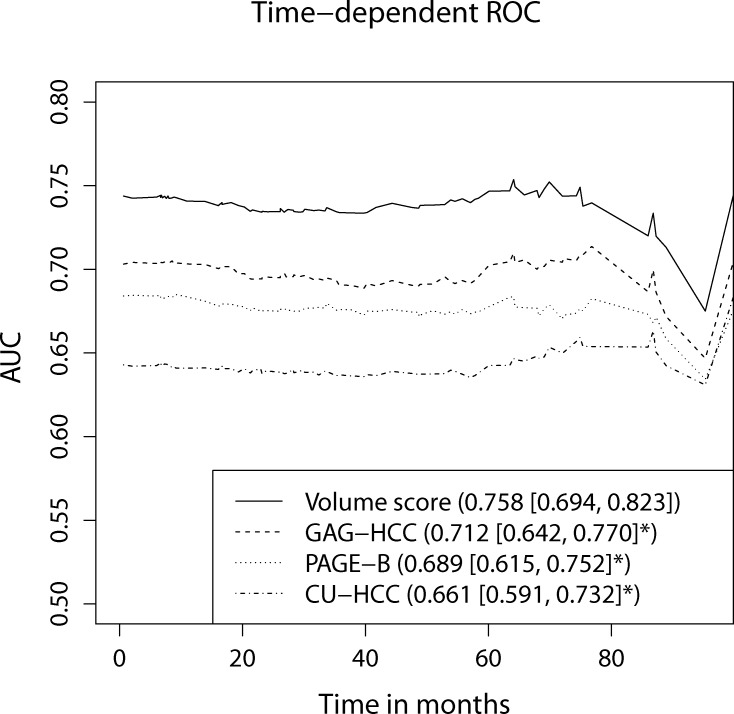
Comparison of HCC probability prediction models by time-dependent ROC analyses.The nomogram-based liver volume score model was compared to previously reported three HCC prediction models. The area under ROC curves (AUCs) were plotted over time for each prediction models. The numbers indicate the integrated AUCs after 100 bootstrapping iterations [95% confidence interval]. Asterisk indicates p < 0.05 against nomogram-based liver volume score model.